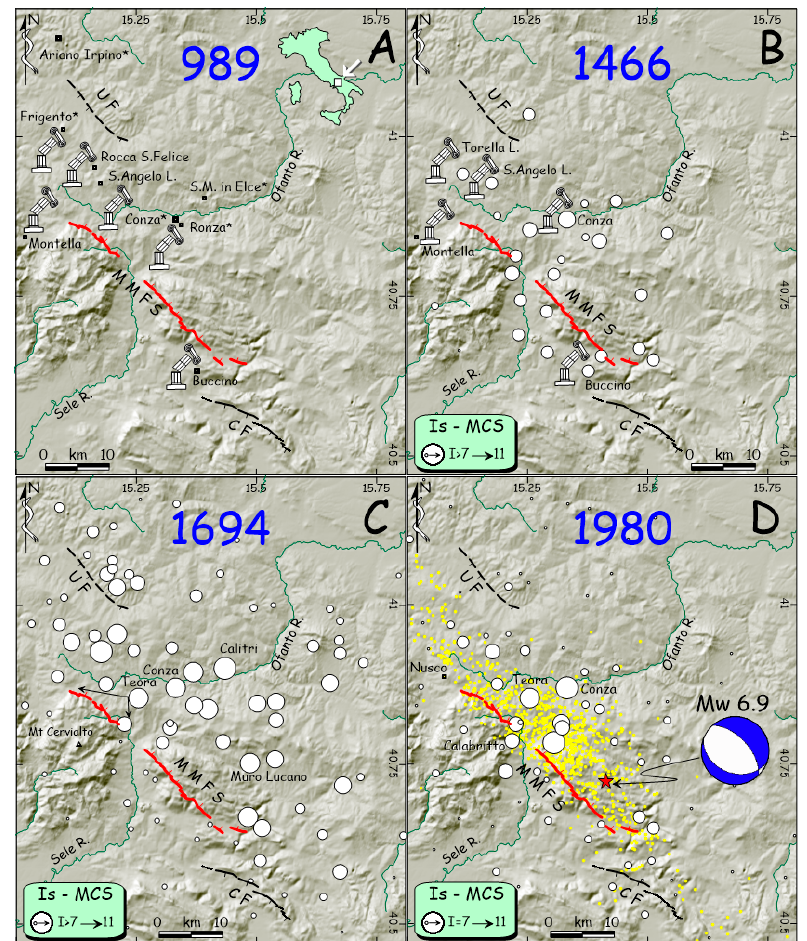
Figure 2. Distribution of effects induced by the 989, 1466, 1694, and 1980 earthquakes (MCS intensities from [7]). ( A ), 989 event; collapsing columns indicate coeval archaeoseismic evidence (see text). Asterisks, damaged villages quoted by contemporary sources. ( B ), 1466 event (data from [20,23]. ( C ), 1694 event; the arrows near Teora indicate the sector of the slope where contemporary accounts describe the opening of a long chasm, which was probably due to surface faulting [7]. ( D ), 1980 event; yellow circles in the background are 1980 aftershocks. Focal mechanism from [24]. MCS: Mercalli–Cancani–Sieberg Macroseismic scale.